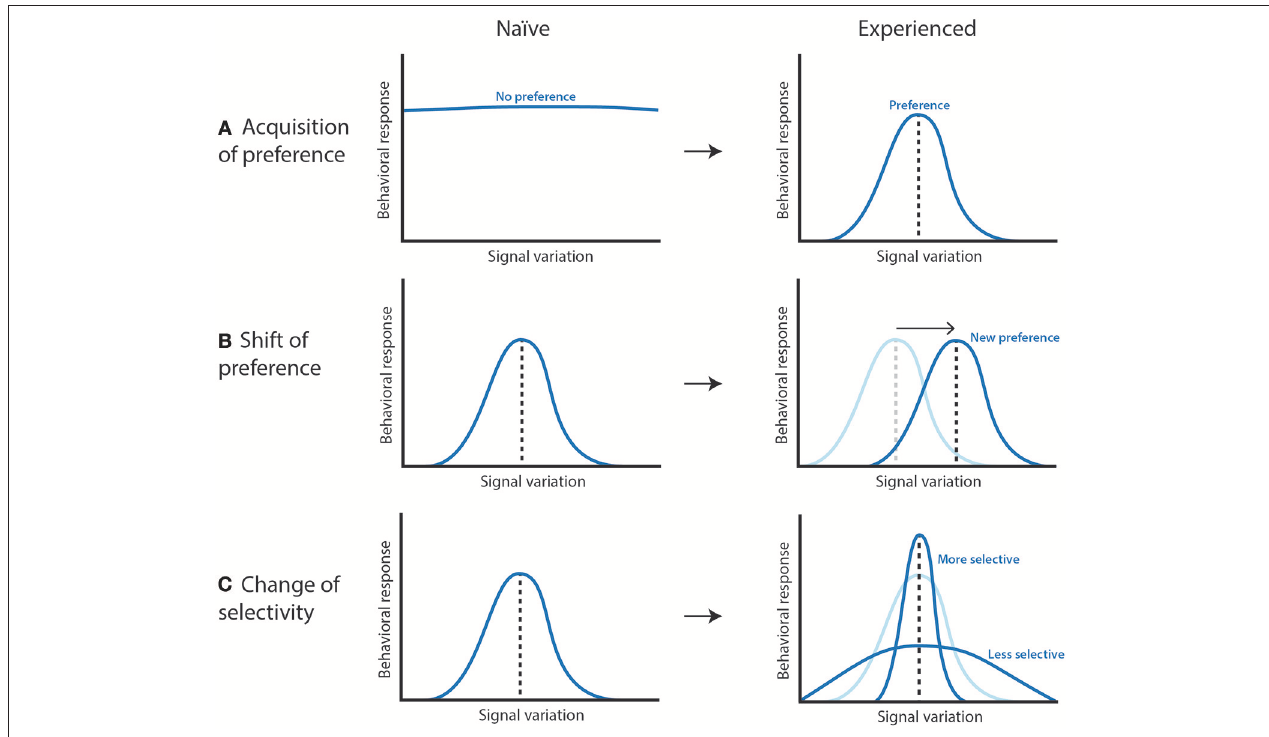
FIGURE 1 | Illustration of how learning can affect a mate preference function. All graphs describe the mate preference of an individual to increasing amount of a sexual signal. (A) Individuals “acquire a preference” when they do not have an innate preference, but acquire one through experience. (B) Individuals “shift their preference” if they have an innate preference for one signal which is changed to another one after experiencing it. (C) A “change of selectivity” involves other types of modifications of the mate preference function, which depends on the individual responsiveness, tolerance and strength of response to a continuously distributed trait. Details on the measure of selectivity can be found in Fowler-Finn and Rodríguez (2012a,b) [Figure adapted from Fowler-Finn and Rodríguez